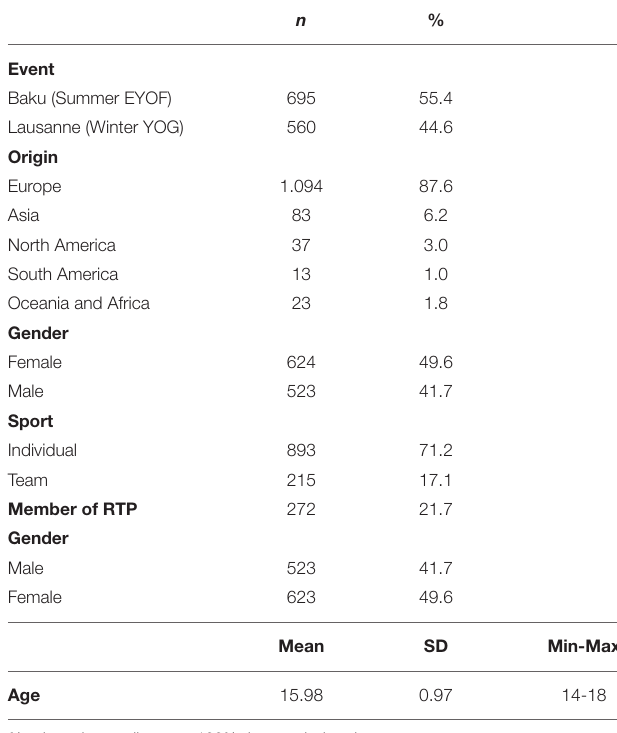
TABLE 3 | Socio-demographic characteristics of the study cohort—phase